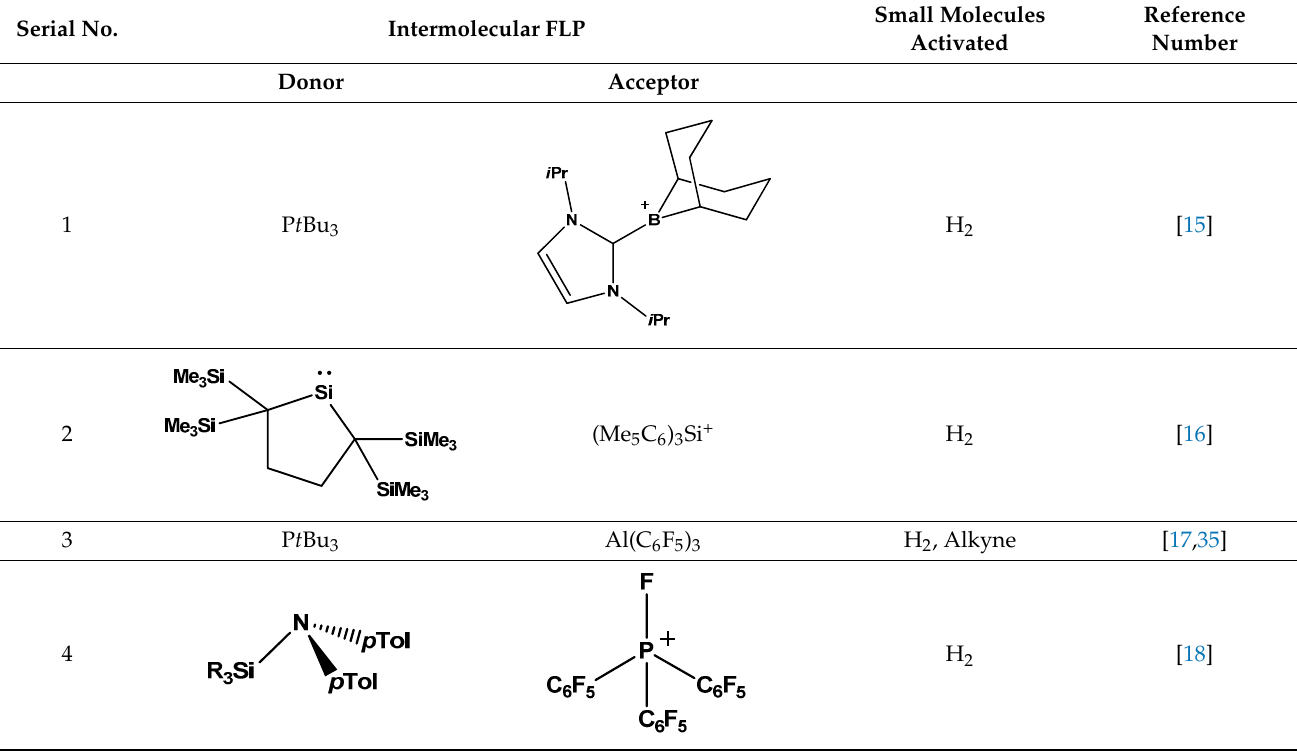
Table 1. Structures of the Lewis acid and Lewis base units of some intermolecular FLPs and their roles. Serial No.